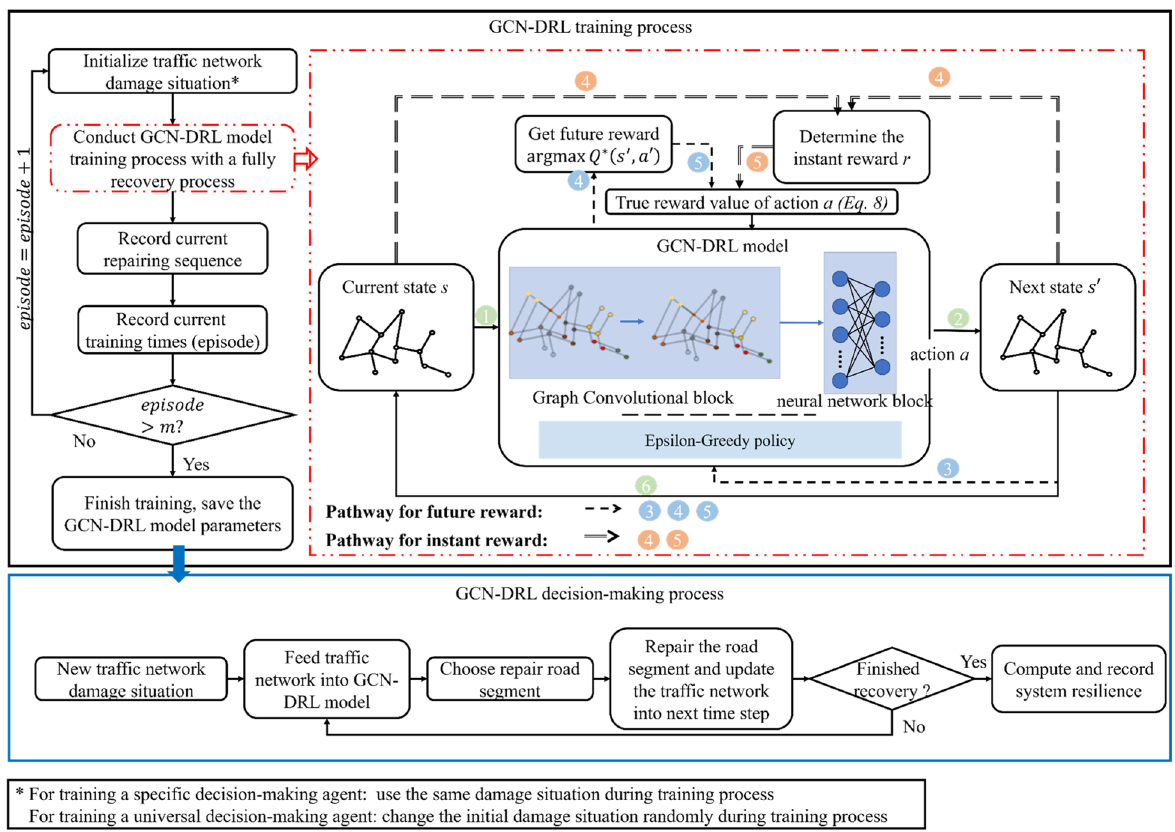
Fig. 2 The proposed GCN-DRL model, training process, and decision-making process ( m is the predefined training